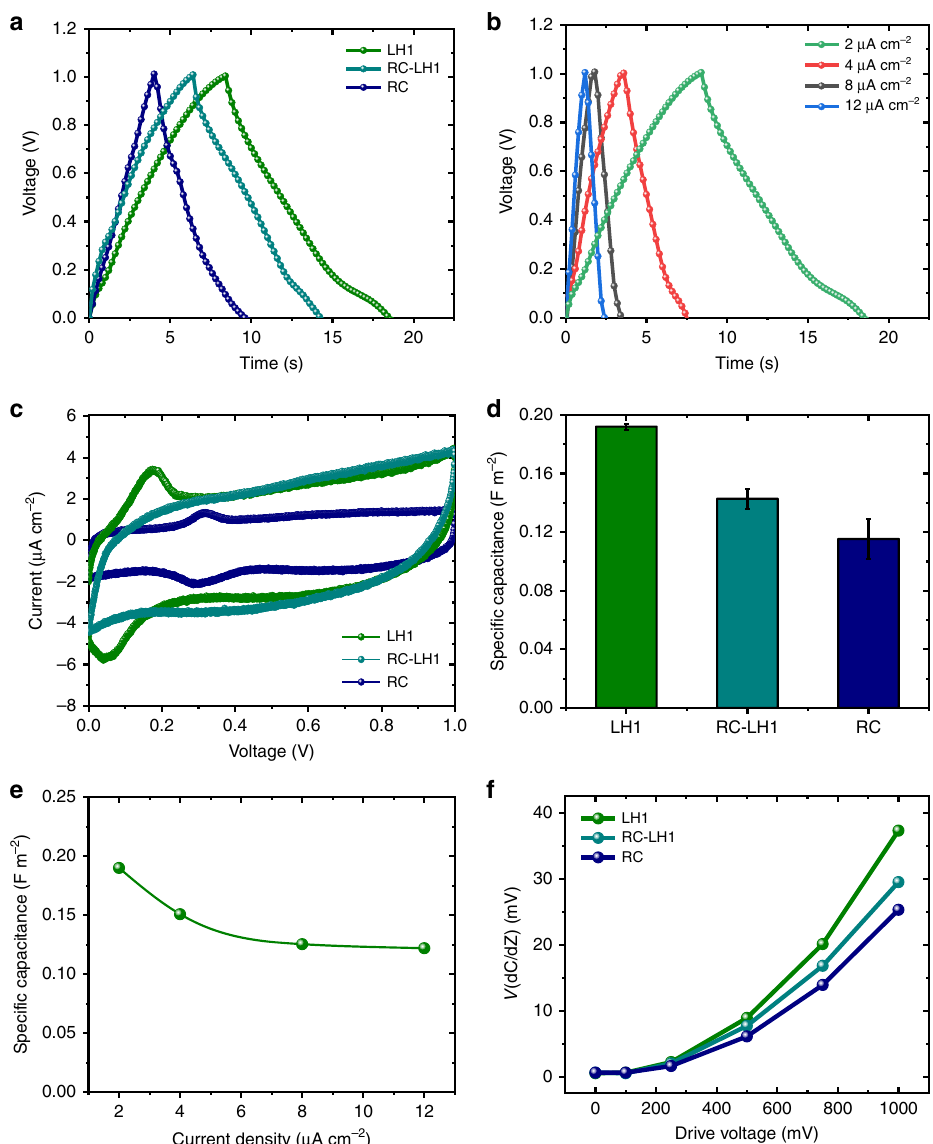
Fig. 5 Capacitances of the biophotonic power cells. a Galvanostatic charge – discharge over a 0 – 1 V range for biophotonic power cells (BPCs) with three different photoproteins namely, reaction centres (RC), light harvesting 1 complexes (LH1), and reaction centre-light harvesting 1 complexes (RC-LH1), at an applied current density of 2 μ A cm − 2 . b Galvanostatic charge – discharge curves for an LH1 BPC at different current densities. c Cyclic voltammetry curves for the three BPCs. d Speci fi c capacitance of the three BPCs; capacitance presented is the average of at least three measurements and the error bar denotes standard deviation. e Speci fi c capacitance of an LH1 BPC at different applied current densities. f Capacitance gradient V (dC/dZ) as a function of drive voltage for the three types of